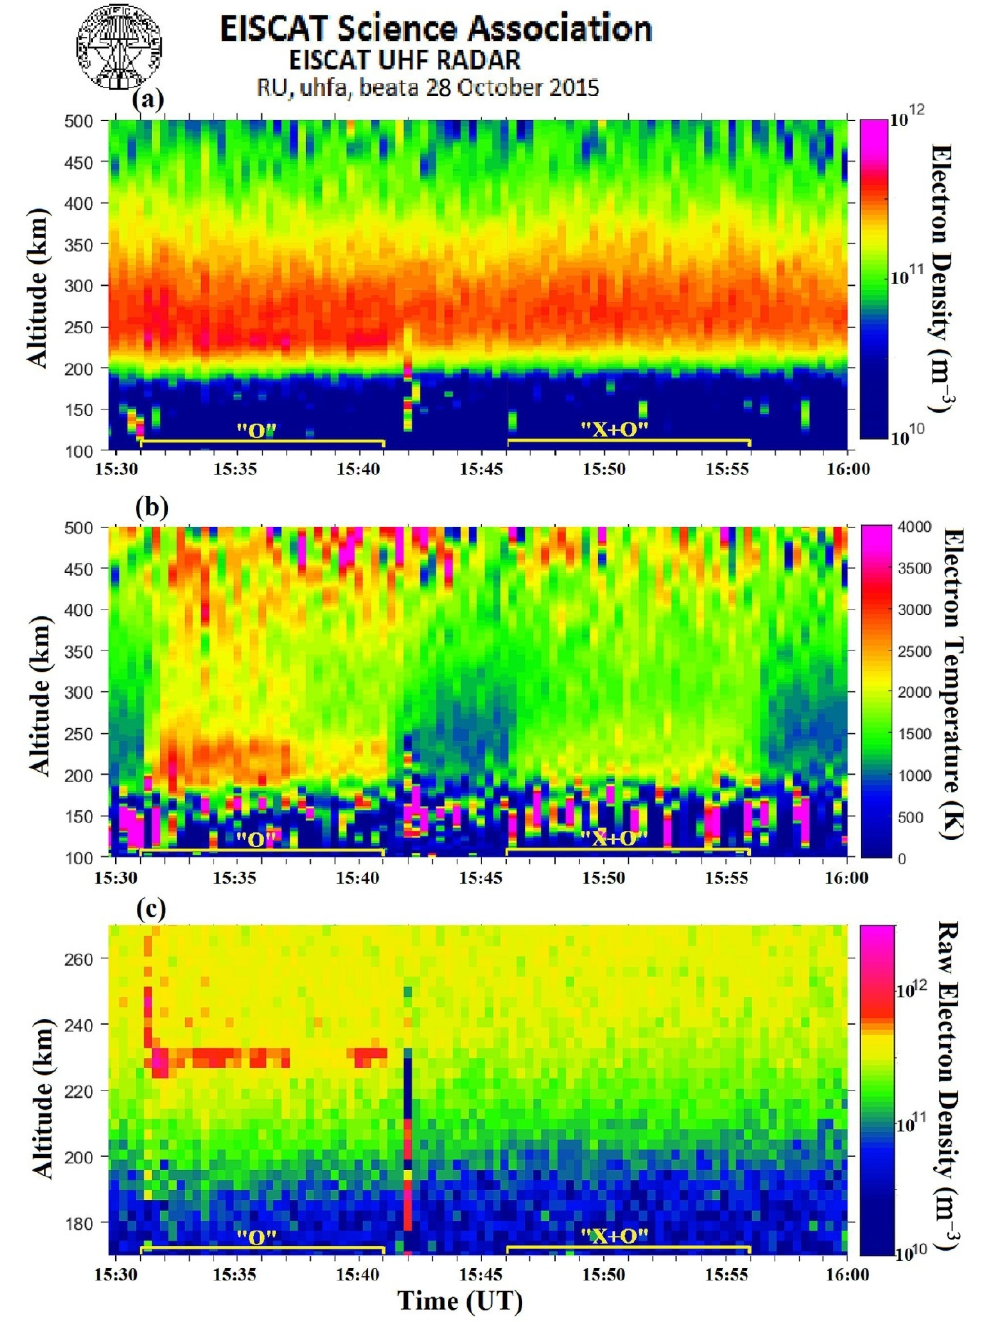
Figure 7. EISCAT UHF radar observations with 20 s integration time on 28 October 2015 from 15:30 to 16:00 UT of ( a ) electron density, ( b ) electron temperature, and ( c ) raw electron density. The pump pulses and polarization of the heater wave are shown on the time axis.